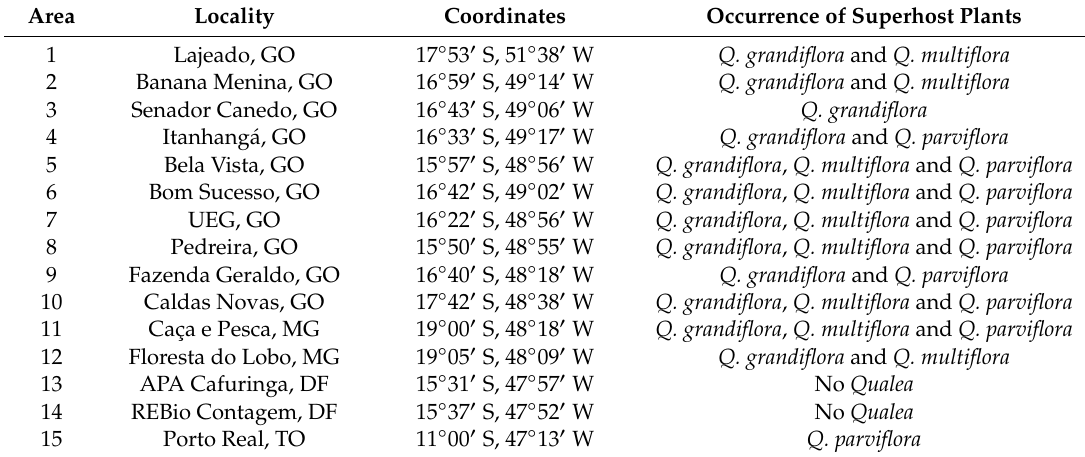
Table 2. Location of Neotropical savanna areas (Brazilian Cerrado) sampled in the study and occurrence of superhost plant species ( Qualea species). Areas correspond to the numbers indicated in the Figure 5. Area Locality Coordinates Occurrence of Superhost